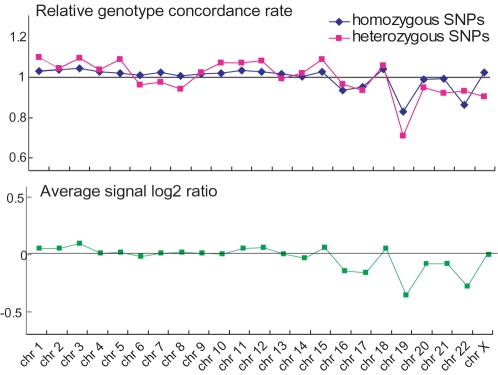
Genotype and CCN analyses in each chromosome.Y axes of the top and bottom panels indicate averaged relative genotype concordance (N = 10 array) and averaged signal log2 ratio (N = 10 array), respectively. Signal log2 ratio above and below 0 indicate gain and loss of CCN, respectively. Two apparently failed array data sets (call rate<50%) were excluded from the analysis.